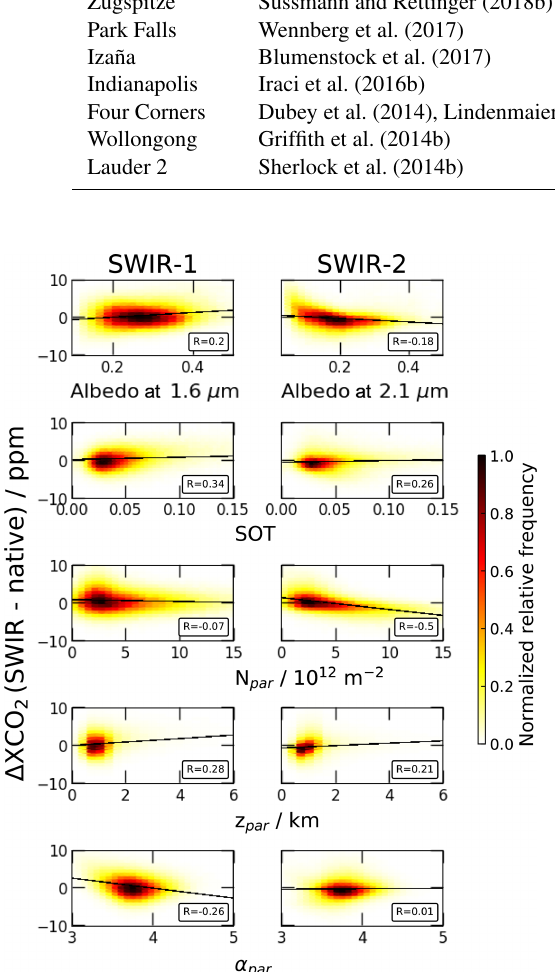
Figure 11. Differences between native GOSAT and the SWIR-1 (left) and SWIR-2 (right) configurations for selected geophysical parameters. Pearson’s correlation coefficient R is shown in the cor- ner of each subplot. The solid line is a linear fit to the data. Color encodes relative occurrence of data points.